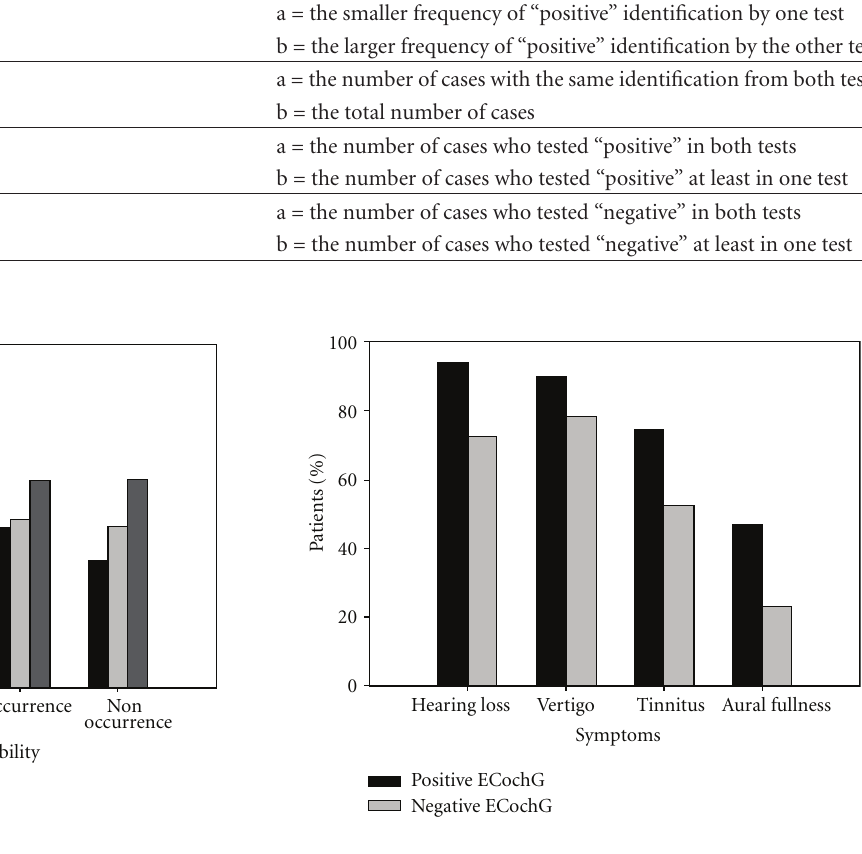
Figure 5: Total, point-by-point, occurrence, and nonoccurrence reliability between ECochG method and AAO-HNS CHE criteria, between ECochG method and Gibson score, and between AAO- HNS CHE criteria and Gibson score.